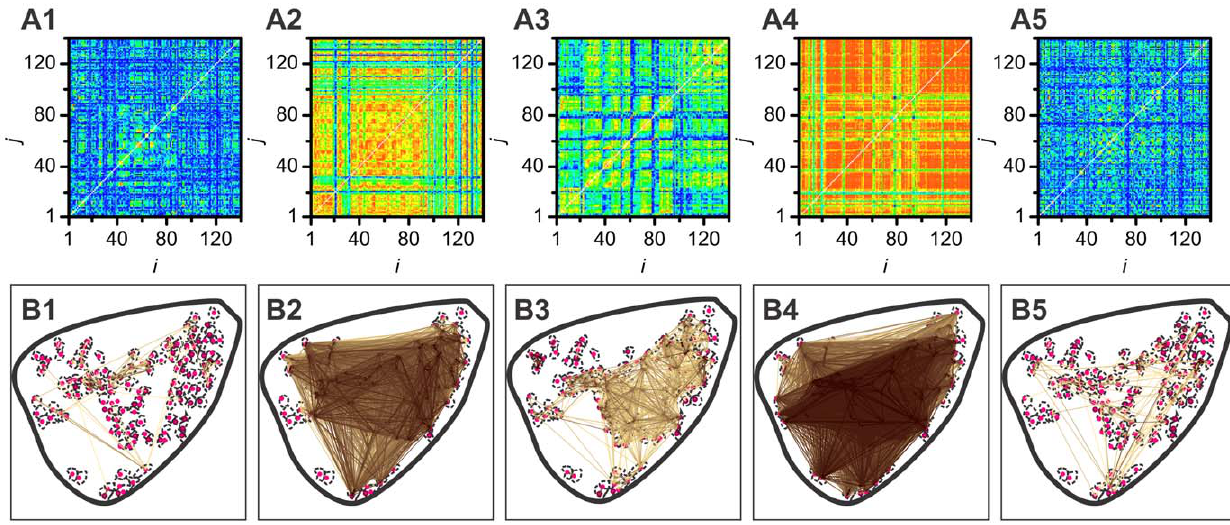
Figure 2. Correlation matrices R (upper row, images A1–A5) and network architectures (lower row, images B1–B5) for all regimes considered in this study. Upper row: correlation matrices for low glucose before stimulation (A1), activation (A2), sustained activity in high glucose (A3), deactivation (A4), and low glucose after stimulation (A5). The color mapping is linear, values of R ij =0.0 and R ij =1.0 depicted in blue and red, respectively. Lower row: network architectures for low glucose before stimulation (B1), activation (B2), sustained activity in high glucose (B3), deactivation (B4) and low glucose after stimulation (B5). Each red dot represents the physical position of a nucleus of a glucose glucose-responsive cell inside the islet of Langerhans. Dashed lines correspond to cell outlines. Pairs of cells whose correlation exceeds R th =0.75 are connected with an arrow. In addition, colors of arrows signify values of R ij : linear coding between 0.75 (yellow) and 1 (dark brown).